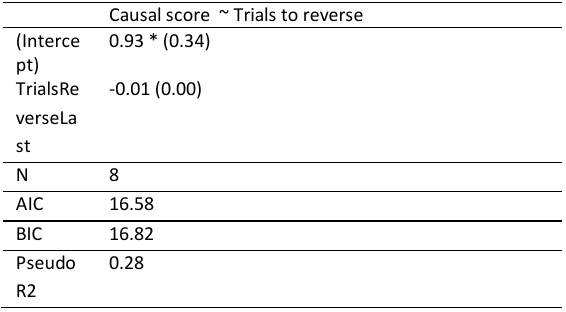
Table 2. Results from the GLM: causal score ~ number of trials in last reversal. The estimate and